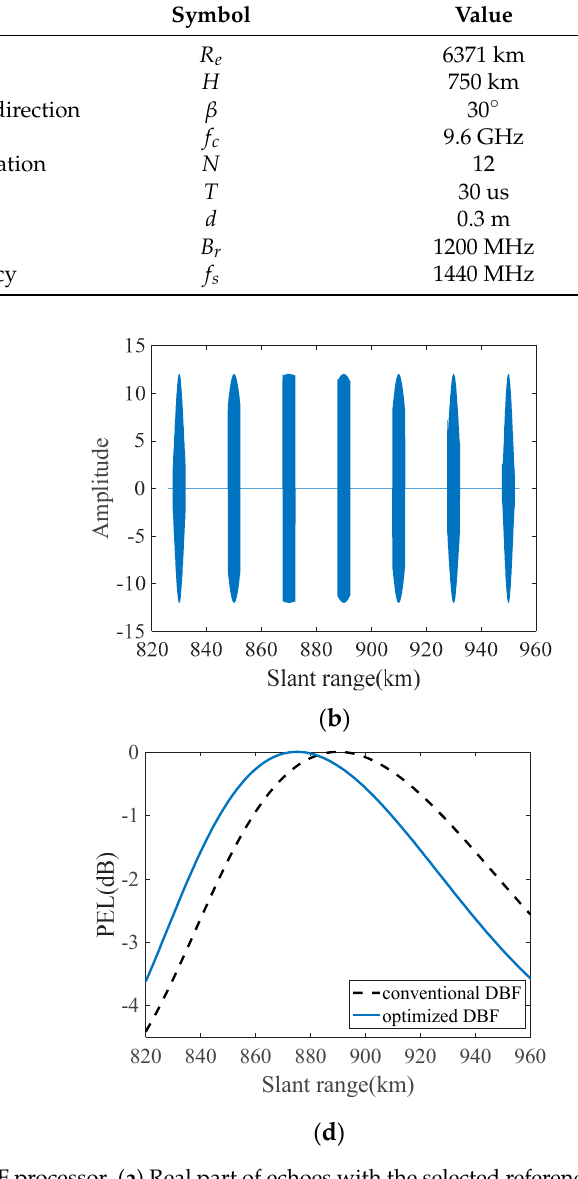
Figure 3. Simulation results processed by the conventional DBF processor. ( a ) Real part of echoes with the selected reference slant range of 890 km. ( b ) Real part of echoes with the optimized reference range of 875 km. ( c ) Residual PEL in ( a , d ). Residual PEL in ( a , b ). Table 1. Simulation parameters.